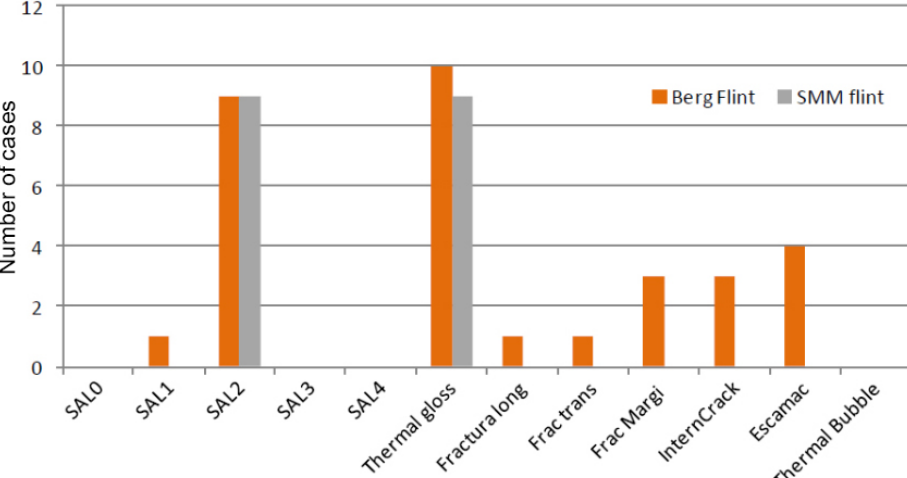
Figure 13. Presence or absence absolute table of SAL and heat alteration features for Bergerac and SMM flint blanks thrown over de ashes of the hearth when temperature had dropped to ~600 ºC.